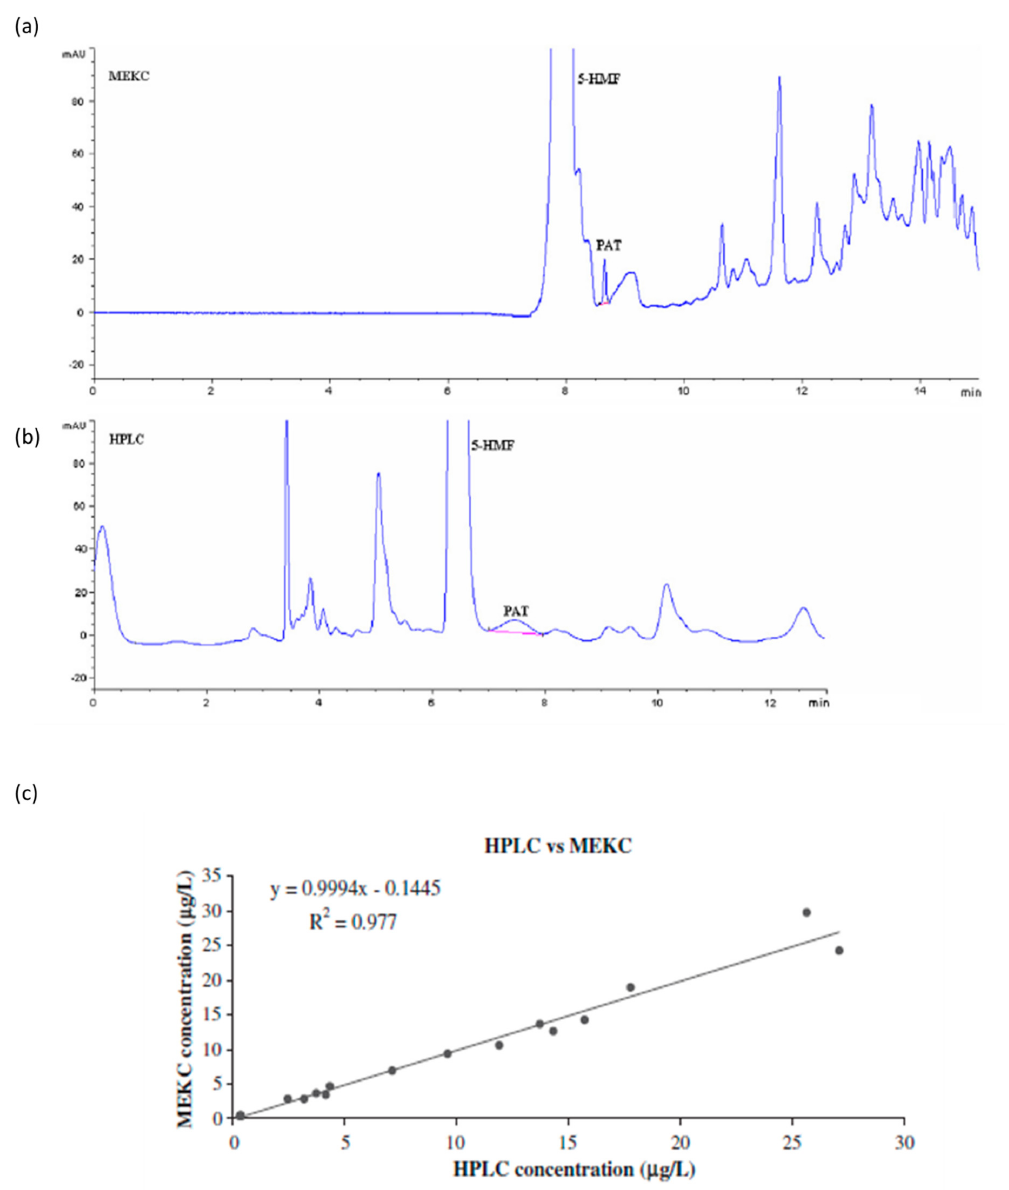
Figure 4. Patulin (PAT) analysis in apple juice by Liquid-Liquid Extraction (LLE) combined with ( a ) Micellar Electrokinetic Chromatography (MEKC) - UV and ( b ) HPLC - UV. ( c ) Plot of MEKC and HPLC concentrations. The results obtained by the two methods were strictly correlated. (Reproduced with permission from Murillo-Arbizou, Food and Chemical Toxicology ; published by Elsevier, 2010 [69]). Vortex-Assisted Low Density Solvent Microextraction (VALDS-ME) is a very recent evolution of the DLLME technique. VALDS-ME consists of the use of non-toxic and low-density extraction solvents, followed by a vortex agitation and, in the final step, by the addition of a salt demulsifier to induce the separation and act as a substitute for centrifugation. It was set up for the first time to analyze AFs in rice samples by HPLC - FD [71] and then this approach was applied in combination